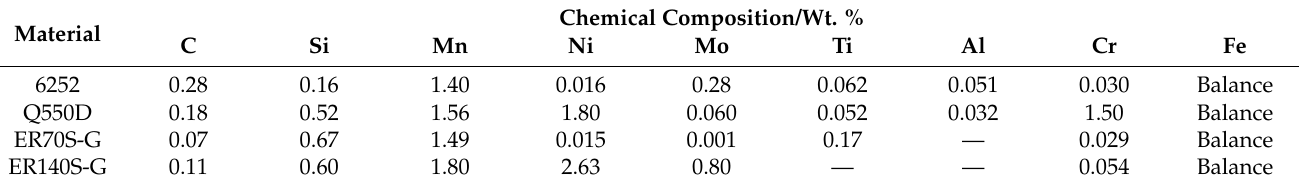
Table 1. Chemical composition.